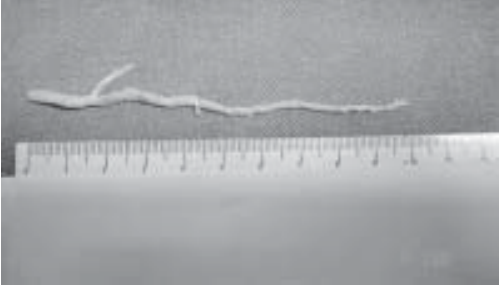
Fig. 3 - Illustrative photograph of the extensive endarterectomy of the anterior interventricular branch performed using the described